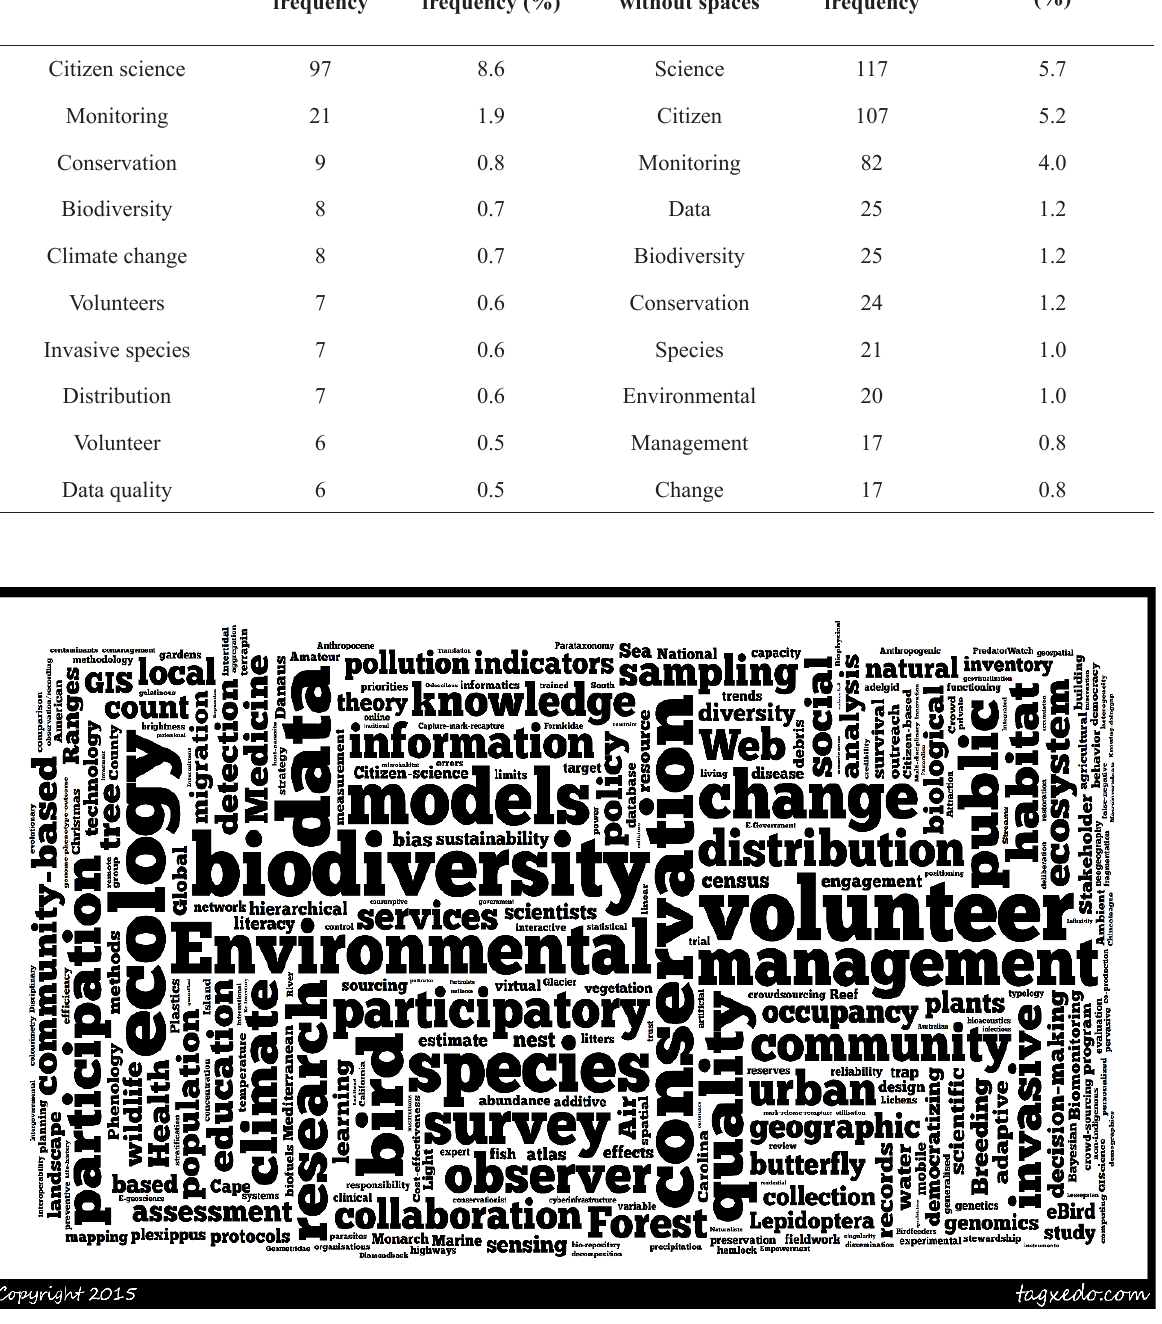
Figure 4 - Word cloud for the first 400 keywords of the peer-reviewed papers analyzed in this study, www.tagxedo.com. The size of each word is proportional to the relative frequency it is mentioned in the